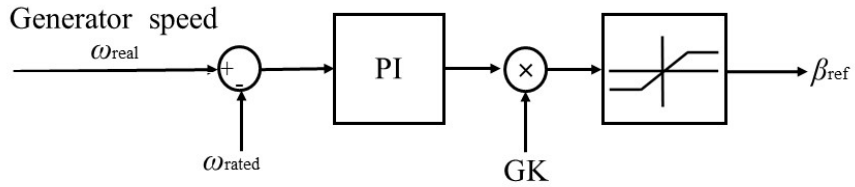
Figure 3. Pitch controller configuration diagram for rated output control.